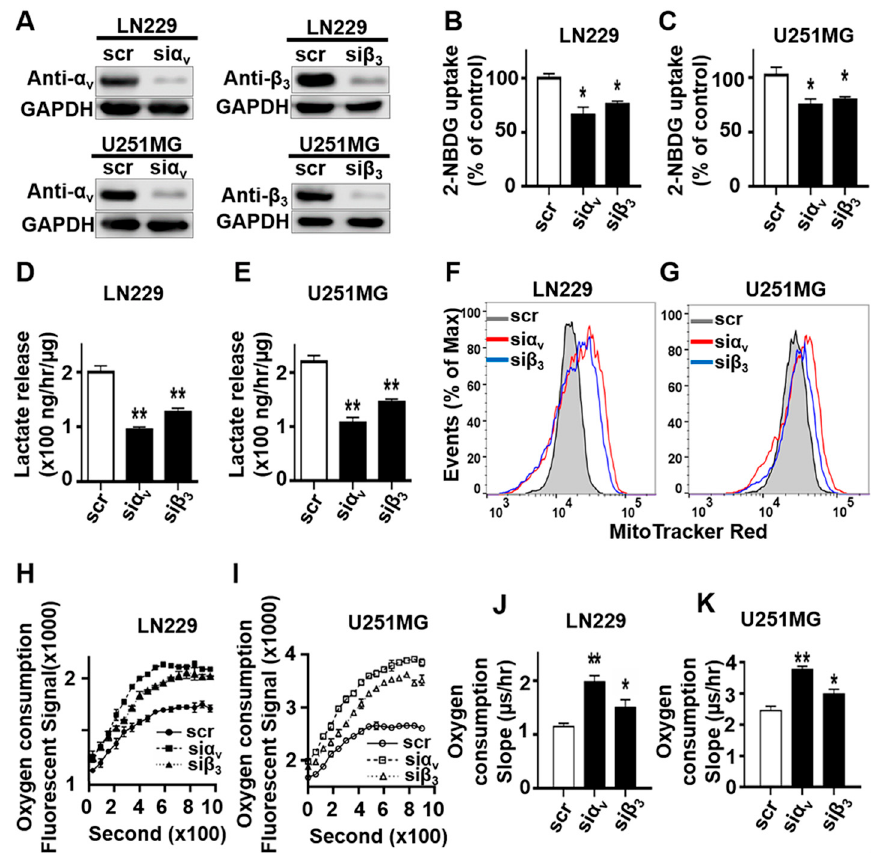
Figure 1. Integrin α v β 3 knockdown inhibits glucose uptake and lactate production but